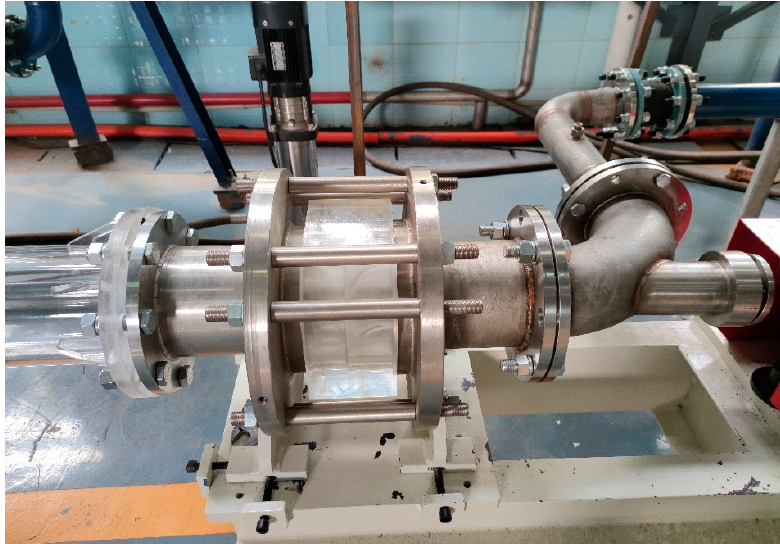
Figure 1. Prototype of the helico-axial pump.